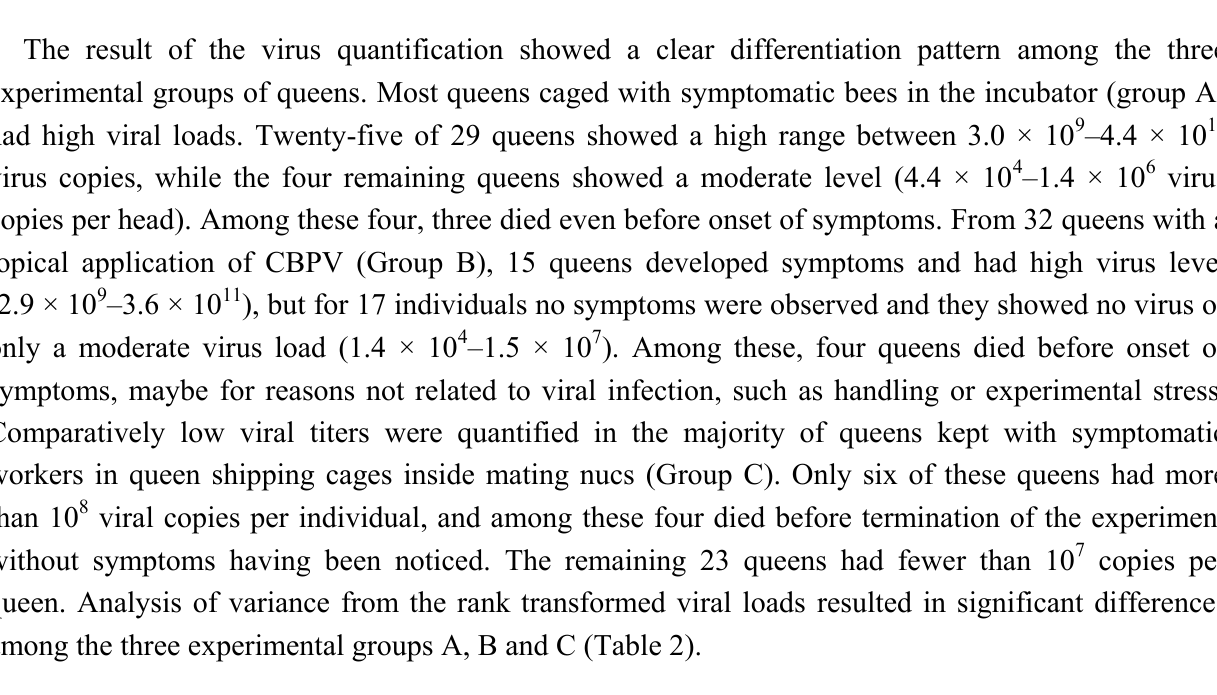
Table 2. Analysis of variance comparing rank transformed viral loads among groups of queens infected applying three different experimental